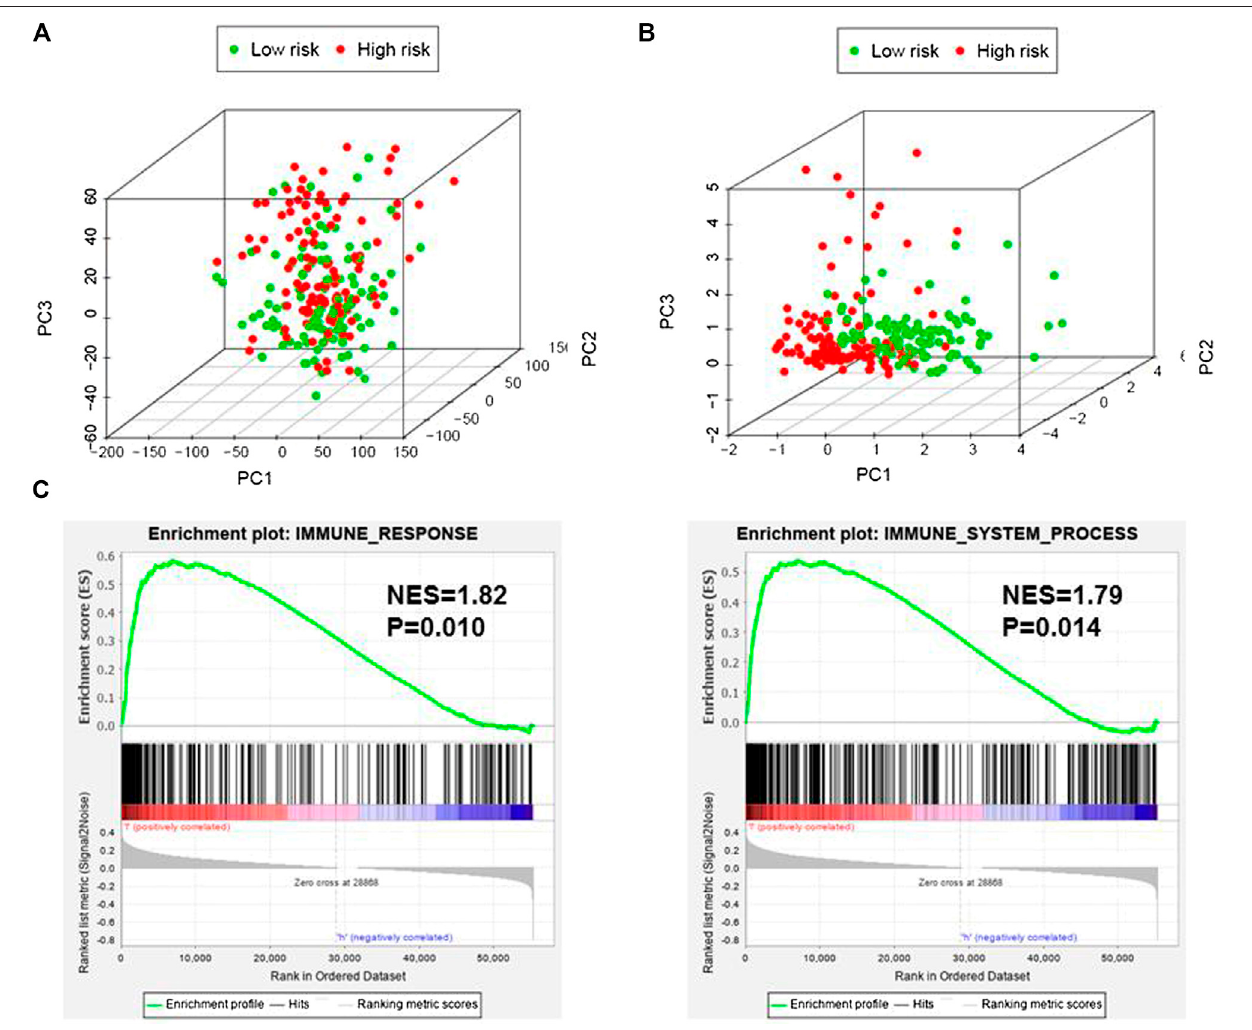
FIGURE 4 | Immune status of the high- and low-risk groups. (A) , Principal component analysis (PCA) showed that whole gene expression pro fi les between the high- and low-risk groups were mixed up. (B) , PCA indicated that the distribution of immune-related genes between the high- and low-risk groups were signi fi cantly different. (C) , Gene set enrichment analysis implied that the low-risk group had adequate immune response and immune system process pathways. NES, Normalized Enrichment Score.